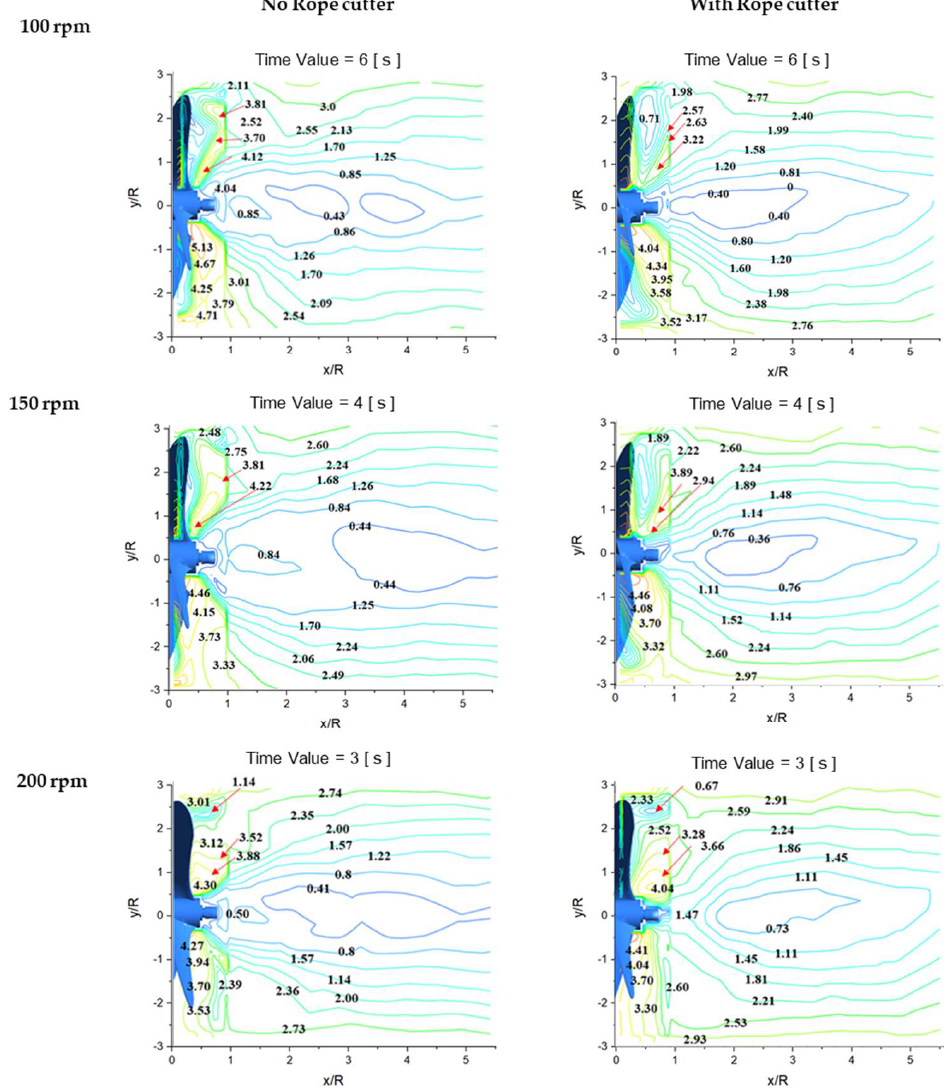
Figure 21. Local velocity magnitude behind the propeller [m/s].